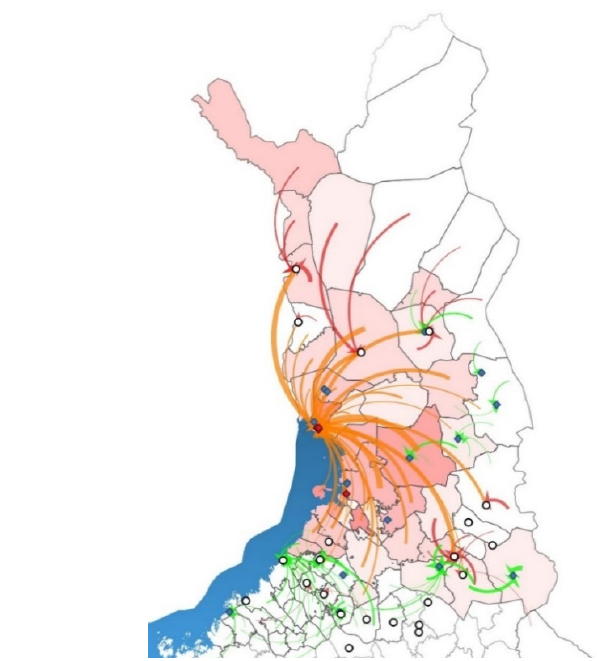
Figure 4. Experimental non-feasible ( left ) and optimized baseline scenario ( right ) pine log flows to sawmills. The thickness of the arrow describes the amount of wood flow. The orange arrow depicts transport deliveries to sawmill of experiment and baseline scenario, the red arrow to railway stations, and the green arrow to sawmills of other companies. The red color scale of the municipalities describes the optimized market share.